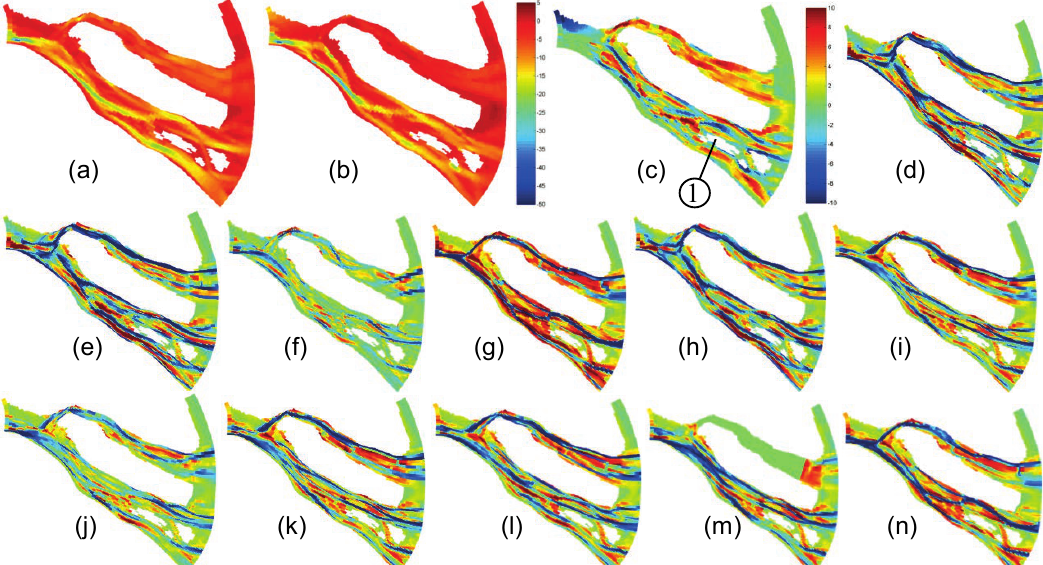
Fig. 3 Bathymetry: (a) Measured 1958, (b) Measured 1997; Erosion/sedimentation patterns: (c) Measured, (d) Scenario 1, (e) Scenario 2, (f) Scenario 3, (g) Scenario 4, (h) Scenario 5, (i) Scenario